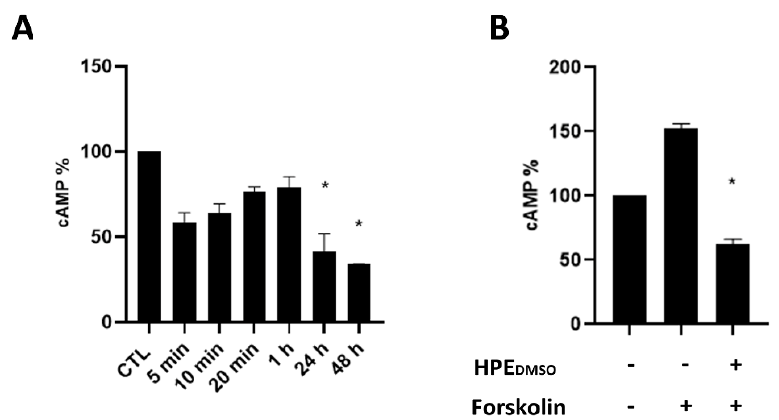
Figure 1. Determination of cAMP in cells treated with H. procumbens root extracted dissolved in DMSO (HPE DMSO ). ( A ) Human primary synoviocytes (FLSs) were treated with 0.1 mg/mL of Harpagophytum procumbens root extract dissolved in DMSO (HPE DMSO ), and after the indicated times, the amount of cAMP was determined by cAMP ELISA kit. ( B ) The amount of cAMP was determined in cells stimulated with forskolin for 20 min or in cells pre-treated with HPE DMSO for 1 h and then stimulated with forskolin for 20 min. * p < 0.05 vs. CTL.